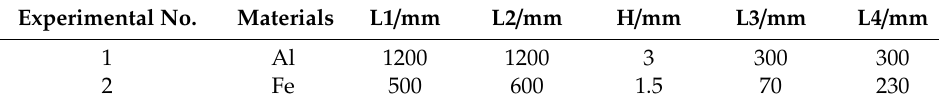
Figure 11. The schematic of electromagnetic acoustic transducer (EMAT)-based guided wave inspection system for the performance evaluation of the linear PA. Table 1. Geometric parameters and materials in experiments.